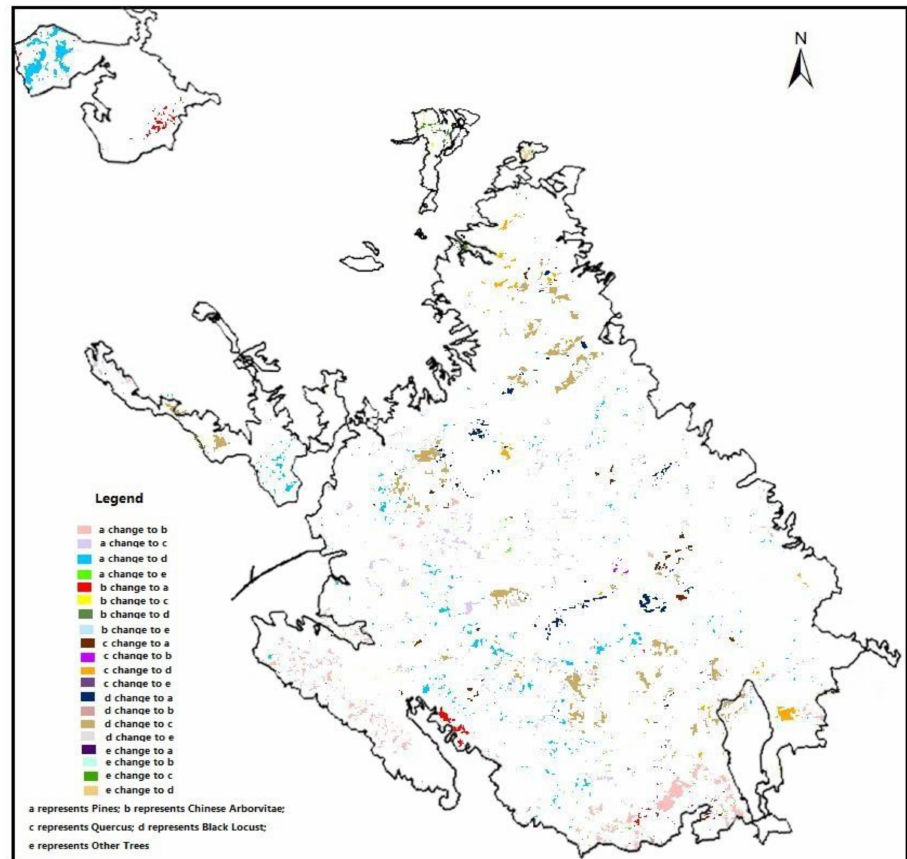
Figure 6. Species distribution change